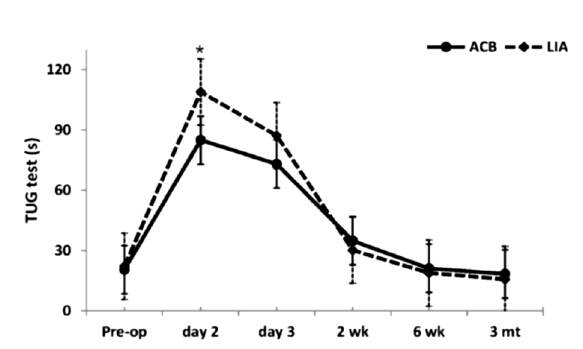
Timed-up and Go test, *= significant at level Fig. 2: